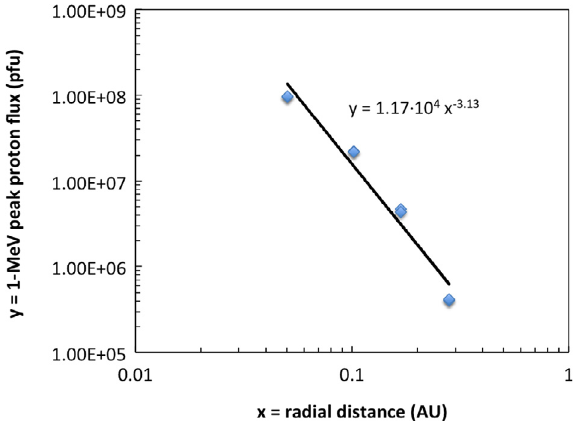
Fig. 8. The modelled scaling of an ESP event. The points give the intensity of the ESP event at 1-MeV proton energy as a function of radial distance resulting from the